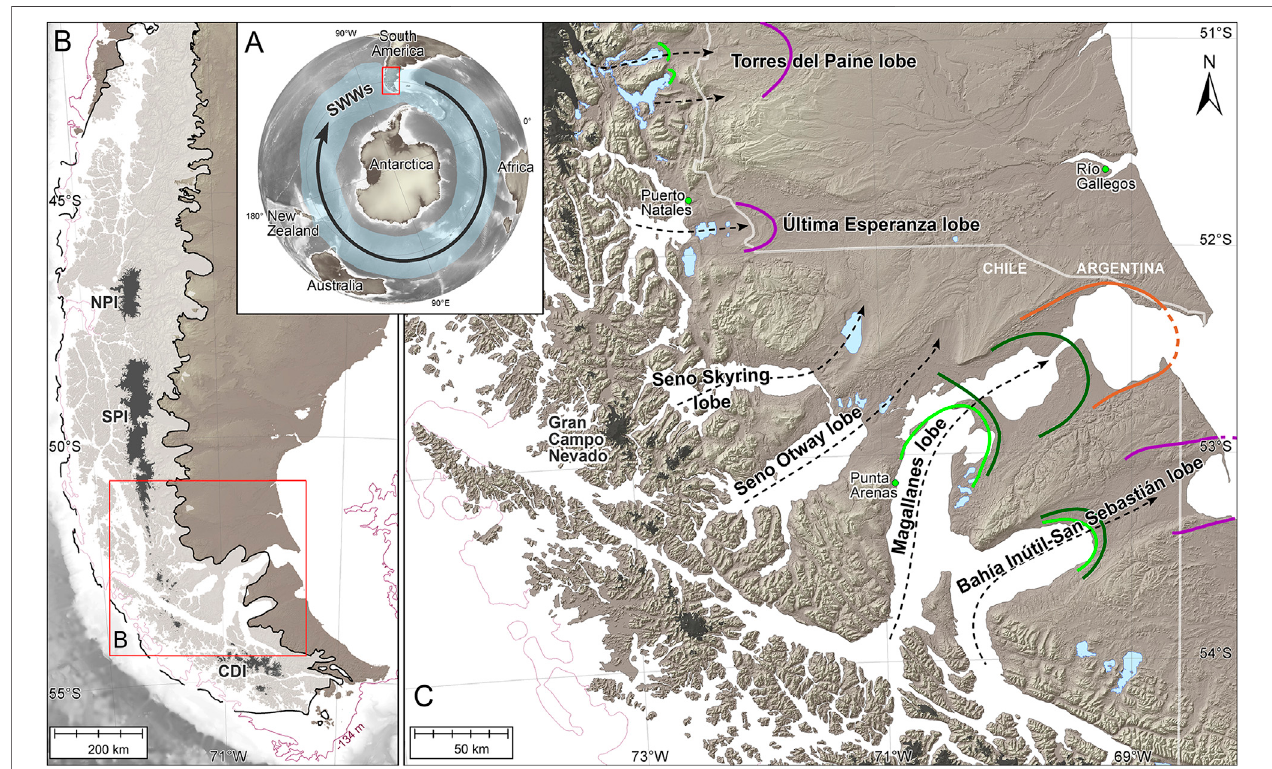
FIGURE 1 | Location Map. (A) . Location of Patagonia and the Southern Westerly Winds belt. (B) . Extension of the Patagonian Ice Sheet during the LGM at 25 ka (pale grey shading, PATICE, Davies et al., 2020). Modern ice is shown by dark grey shading; NPI: Northern Patagonian Ice fi eld, SPI: Southern Patagonian Ice fi eld, CDI: Cordillerade Darwin Ice fi eld.Bathymetric contour of-134 mindicates approximate fall ineustatic sea levelduringthe LGM (Lambeck et al.,2014). (C) . Location ofSeno Skyring ice lobe in Southernmost Patagonia and adjacent ice lobes. Coloured arcs correspond tothe age ofdated moraine belts from the last glacial cycle:orange corresponds to MIS4, purple to MIS 3 and green to MIS 2 (Darvill et al., 2015; García et al., 2018; Peltier et al., 2021). Black dashed lines are hypothesised fl ow lines of major outlet lobes. Background image is a Copernicus DEM (30 m resolution).